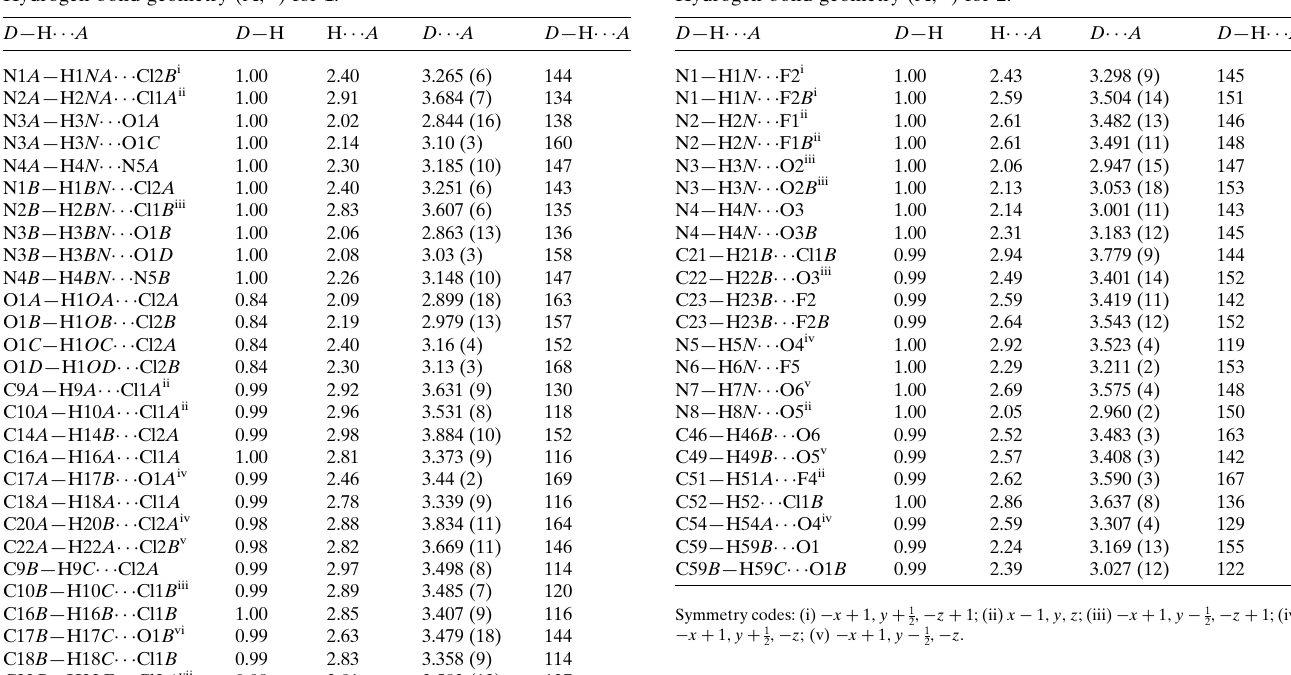
Table 3 Hydrogen-bond geometry (A˚ , (cid:3) ) for 1 .